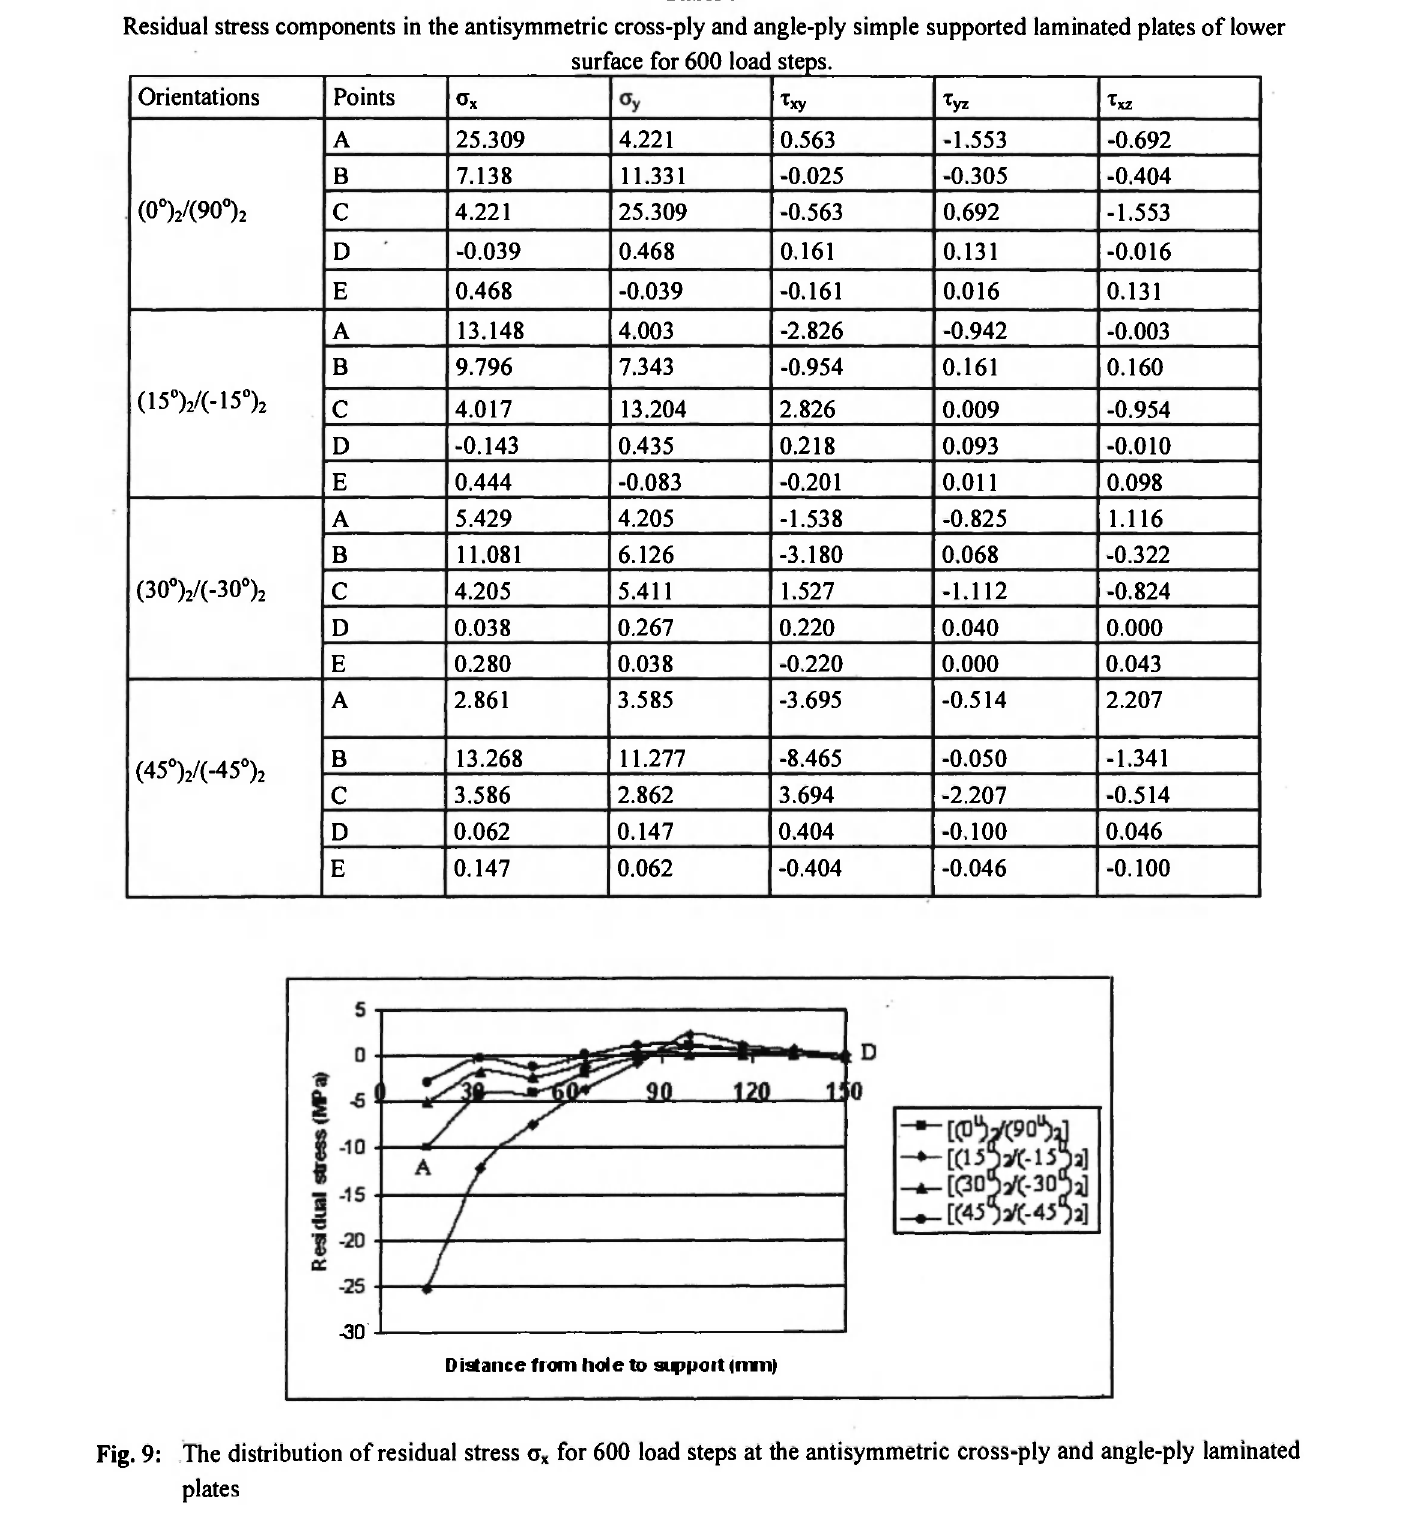
Fig. 9: The distribution of residual stress σ χ for 600 load steps at the antisymmetric cross-ply and angle-ply laminated plates